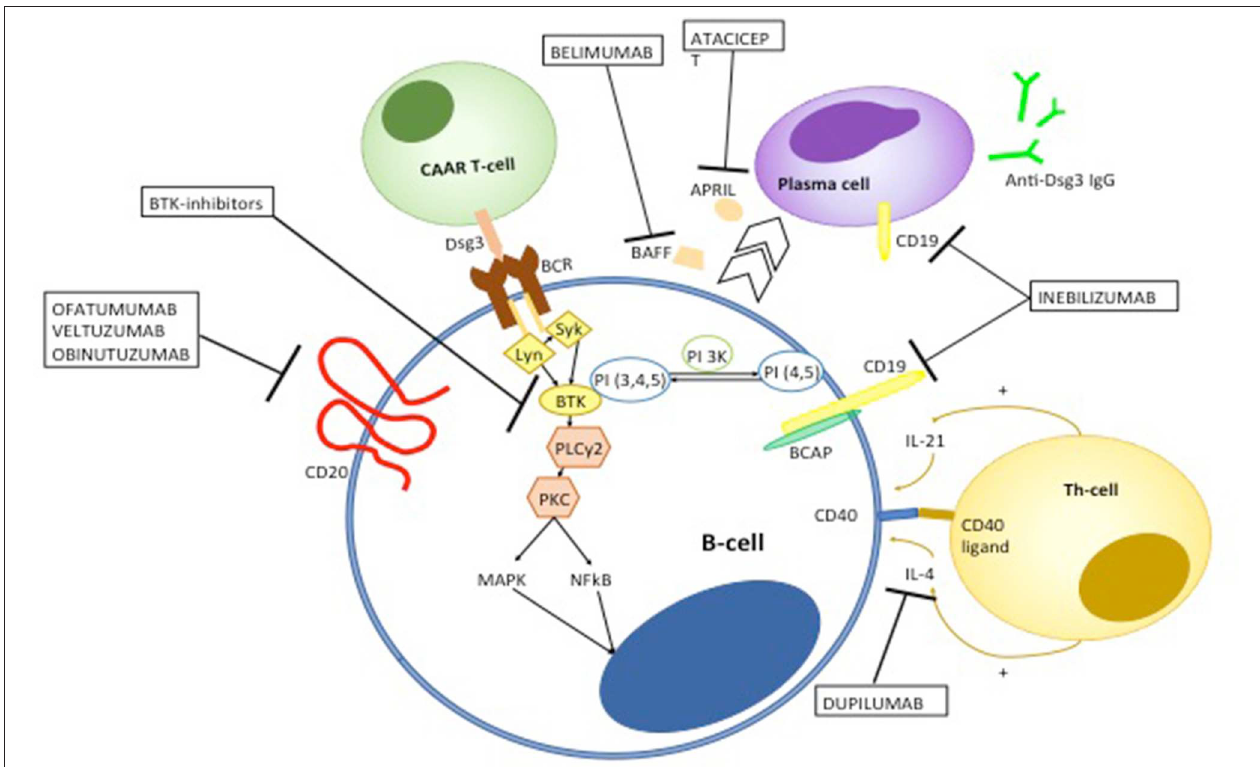
FIGURE 9 | Emerging therapies targeting auto-reactive B and T-cells in pemphigus. Ofatumumab, veltuzumab, and obinutuzumab are fully human or humanized monoclonal antibodies targeting CD20. Ofatumumab and veltuzumab are class I anti-CD20 monoclonal antibody, with a higher capacity of binding CD20 and inducing complement-dependent cytotoxicity compared to RTX. Obinutuzumab is a class II anti-CD20 monoclonal antibody, that has an increased affinity to the Fc γ III receptor, resulting in a more potent antibody-dependent cytotoxicity. Bruton kinase (BTK) inhibitors interfere with B cell activation. BCR signaling induces migration of BTK from the cytosol to the cell membrane, though the interaction with phosphatidylinositol 3,4,5-triphosfate generated by phosphoinositide 3-kinase (PI3K). BTK is activated by Lyn and Syk and then actives downstream molecules including phospholipase C gamma 2 (PLC γ 2) and Protein kinase C. The latter in turns activate different pro-inflammatory pathways including mitogen associated protein kinases (MAPK) and Nuclear Factor k B (NFkB). Chimeric autoantibody receptor (CAAR)-T-cells are engineered T-lymphocytes which express Dsg3 ectodomain, which allows recognition and subsequent killing of B-cells targeting Dsg3. Belimumab and atacicept target B-cell derived B-cell activating factor (BAFF) and a proliferation-inducing ligand (APRIL), respectively, which promote differentiation toward autoantibody-producing plasma cells. Inebilizumab is a monoclonal antibody targeting CD19 which is not only expressed on B cells but also plasma cells. Dupilumamb is a monoclonal antibody targeting interleukin (IL-4), which is one the main cytokine produced by T helper 2 cells and T follicular helper cell which induces autoantibody production by autoreactive